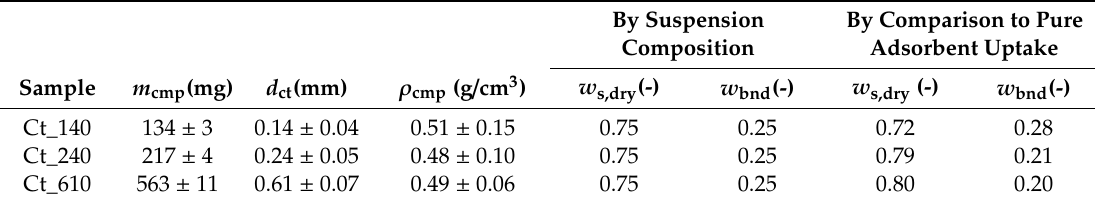
Table 1. Sample mass and geometry, the adsorbent content was estimated when mixing the coating suspension and confirmed later by comparing the sample’s uptake with the pure adsorbent powder isotherm (c.f. Section 3.1).